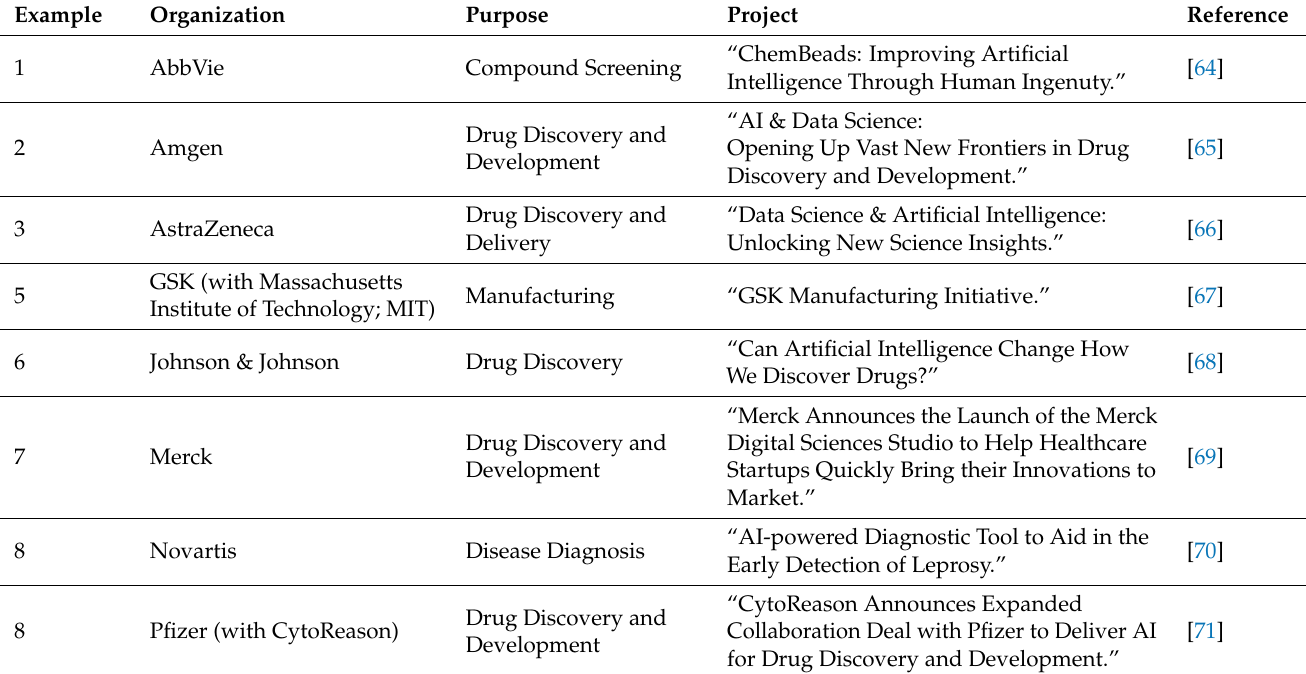
Table 2. Examples of Ten Biopharmaceutical Companies’ Harnessing AI/ML/DL via Publicly Available